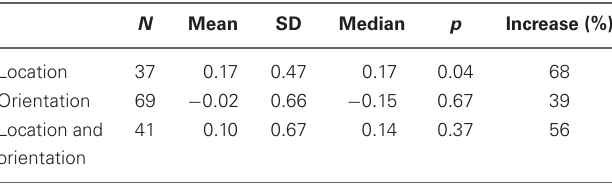
Table 2 | Overview of results for change in pause length on trial t as compared to trial t − 2 for the three types of receiver